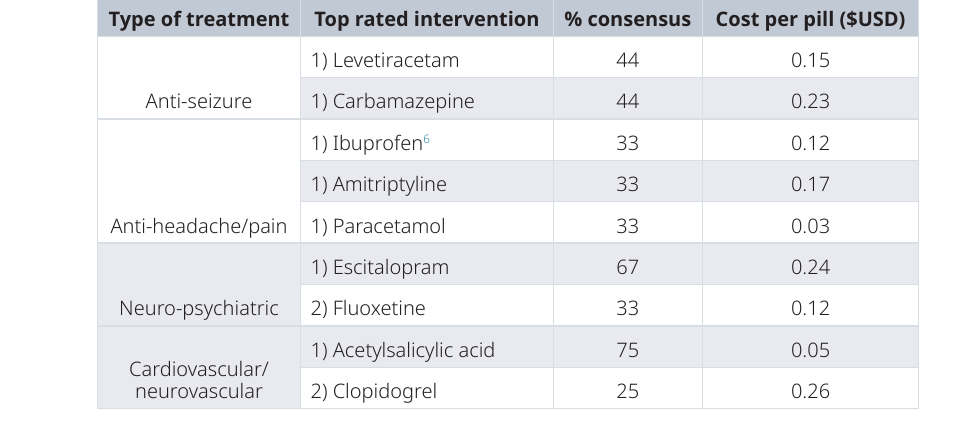
Table 5. Top two priority treatments for select treatment categories. Type of